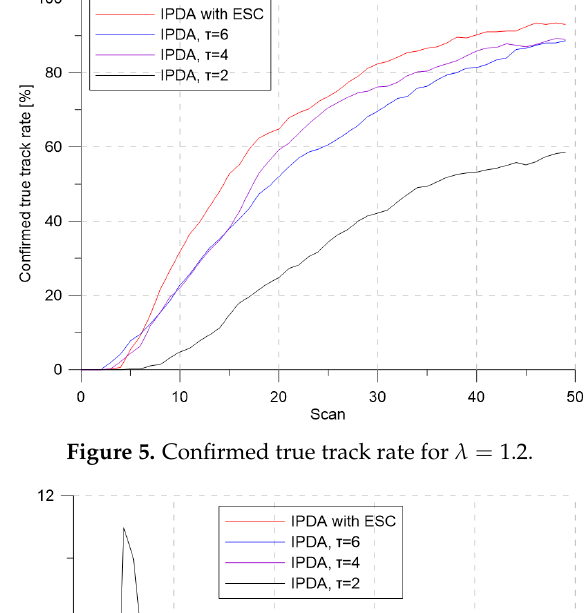
Figure 5. Confirmed true track rate for λ = 1.2.